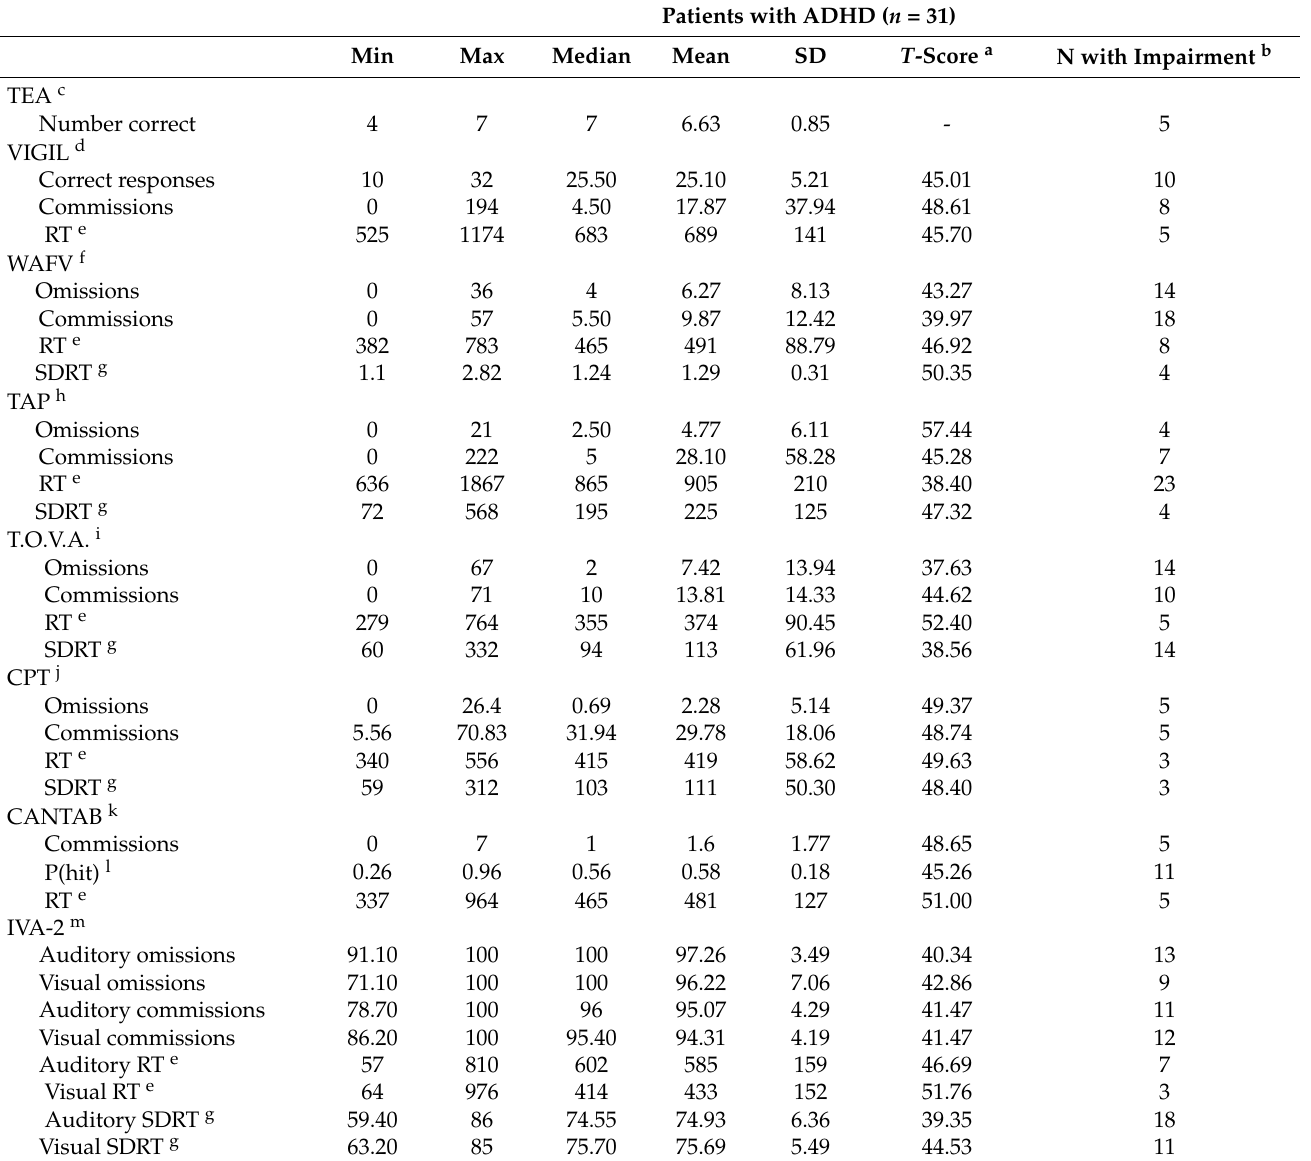
Table 2. Vigilance and sustained attention test performances of patients with